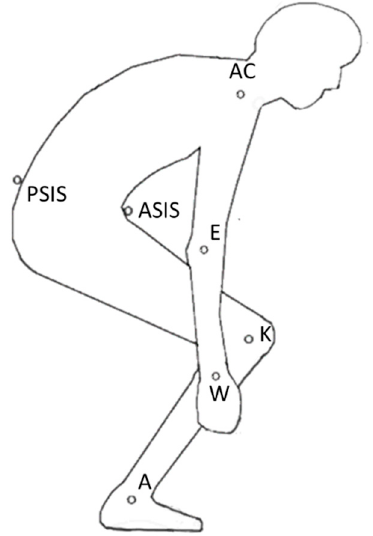
Figure 8. Palpable anatomical landmarks required to use the planar linked segment model proposed by Chaffin enriched with the estimation of the back extensor muscle moment arm and line of action as suggested in the present paper. W = wrist joint center; E = elbow joint center; AC = acromion; PSIS = posterior superior iliac spine; ASIS = anterior superior iliac spine; K = knee joint center; A = ankle joint center.